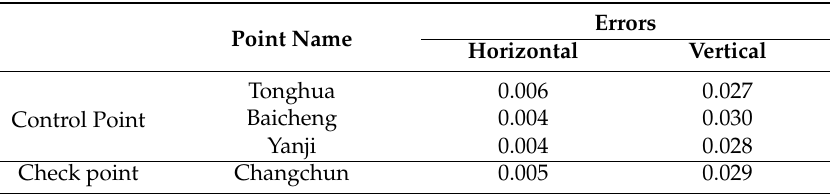
Table 3. Accuracy of transformation parameters (m).